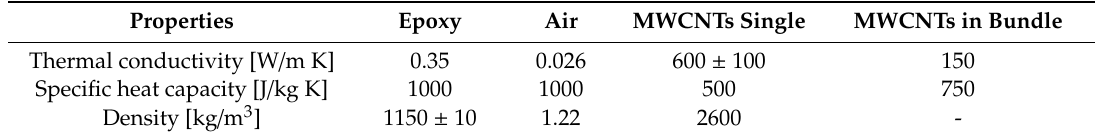
Figure 3. Schematic representation of the Pulsed Thermography experimental setup.